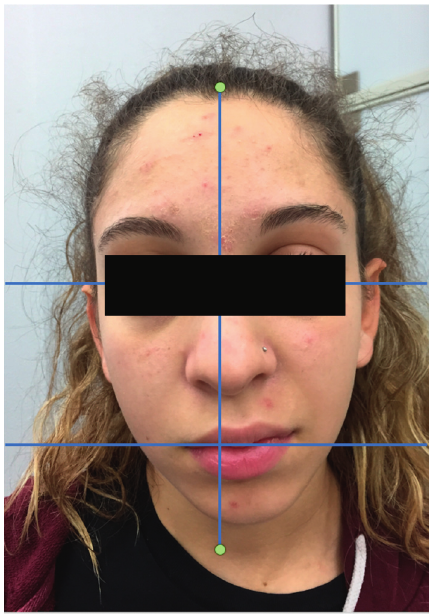
Figure 1: Facial observation before